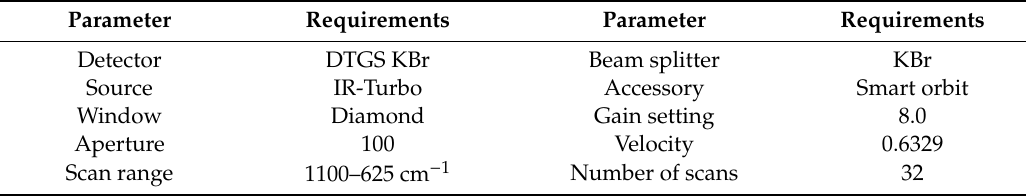
Table 4. Set-up of ATR-FTIR spectrophotometer